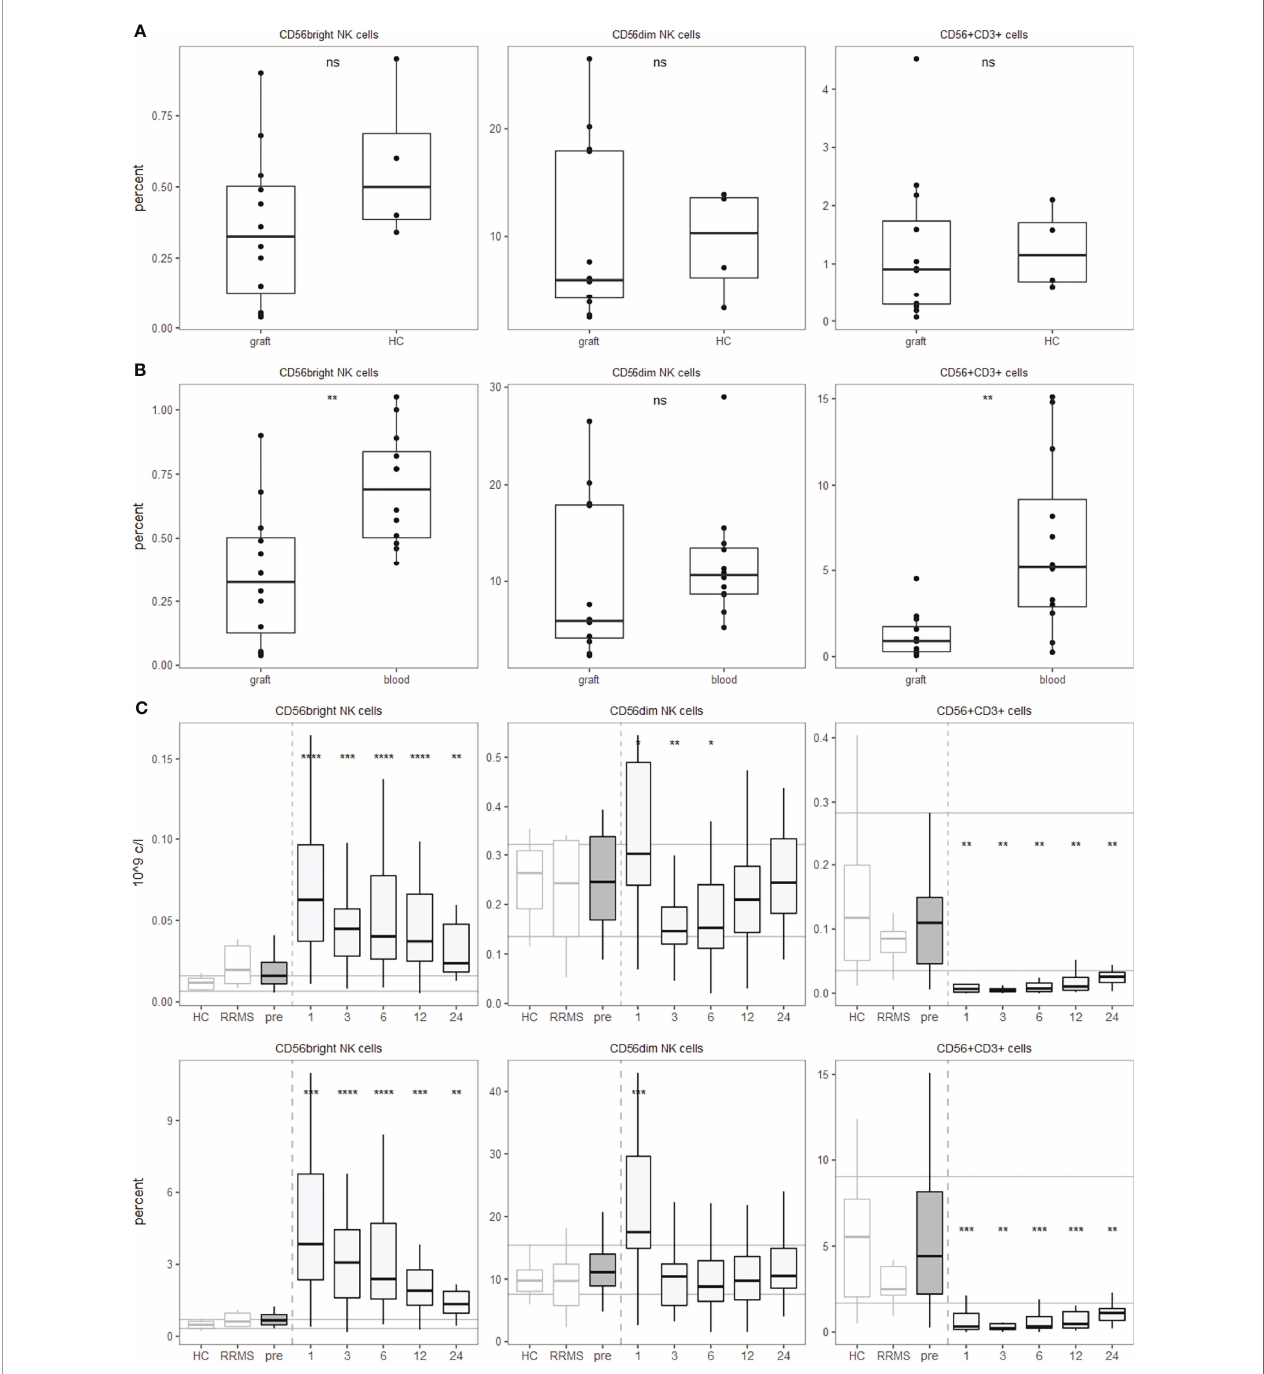
FIGURE 3 | aHSCT but not the mobilization regimen is followed by a shift from CD56 dim towards CD56 bright NK cells and a strong decrease in innate-like CD56 +CD3+ T cells. PBMCs were stained with surface fl uorophore-conjugated antibodies and analyzed by fl ow cytometry. Percentages are fractions of total PBMCs and absolute cell numbers were calculated from lymphocyte numbers measured in clinical routine. (A) NK and innate-like T cell percentages in the graft after the mobilization regimen, but before aHSCT compared to three leukapheresis and one buffy coat. Number of samples were graft = 12, HC =4. (B) NK and innate-like T cell percentages in the graft after the mobilization regimen, but before aHSCT compared to the pre-aHSCT PBMCs of the respective patients. Number of samples were graft = 12, blood = 12. (C) Absolute (top) and relative (bottom) NK and innate-like T cell dynamics pre- and post-aHSCT. Horizontal lines re fl ect the median and 10 th /90 th percentile of age- and sex-matched HCs. Number of samples were pre = 26, M1 = 21, M3 = 19, M6 = 27, M12 = 25, M24 = 11, HC = 12, RRMS = 10. As a global test, ANOVA was used, and in case of signi fi cance followed by pairwise comparisons (HC vs 1, 3, 6, 12 and 24 months) using